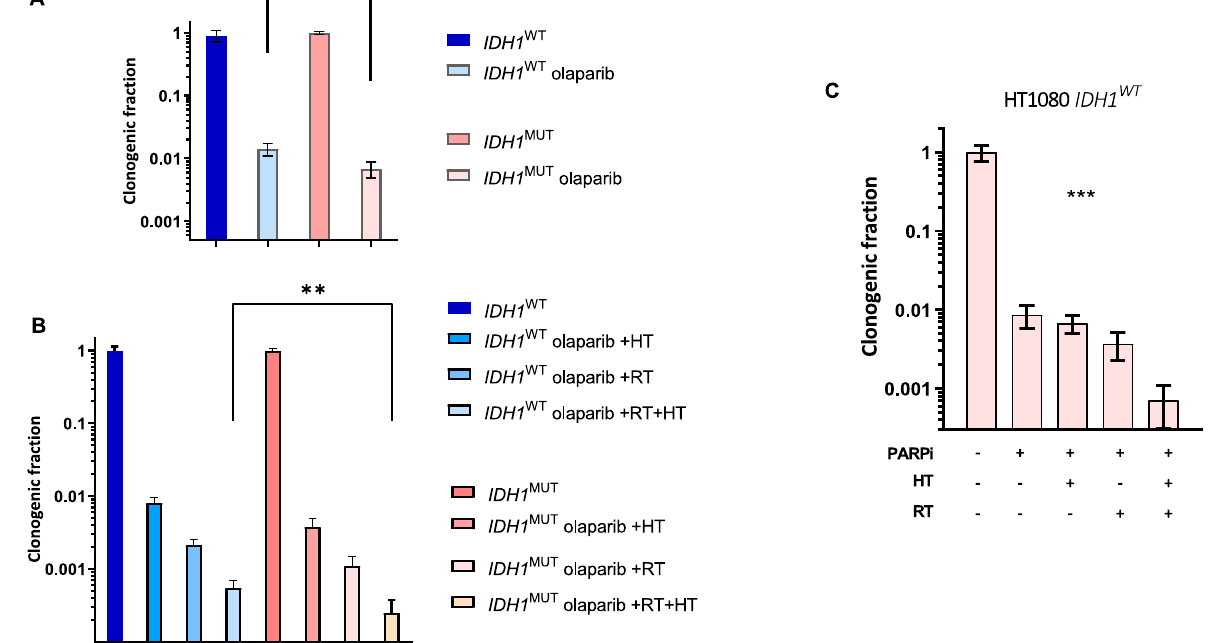
Figure 6. Clonogenic survival of IDH1 WT and IDH1 MUT cells after olaparib (PARPi) treatment (10 µ M, 48 h) combined with hyperthermia (HT) and radiotherapy (RT). ( A , B ) IDH1 WT and IDH1 MUT HCT116 cancer cells and ( C ) hyperthermia1080 chondrosarcoma IDH1 MUT cells after indicated combination treatments. p values were determined using one-way ANOVA to reveal the difference between cisplatin-treated and -untreated cells, using Tukey correction for multiple comparisons. Significance levels are shown by ** p < 0.01 and *** p < 0.001.